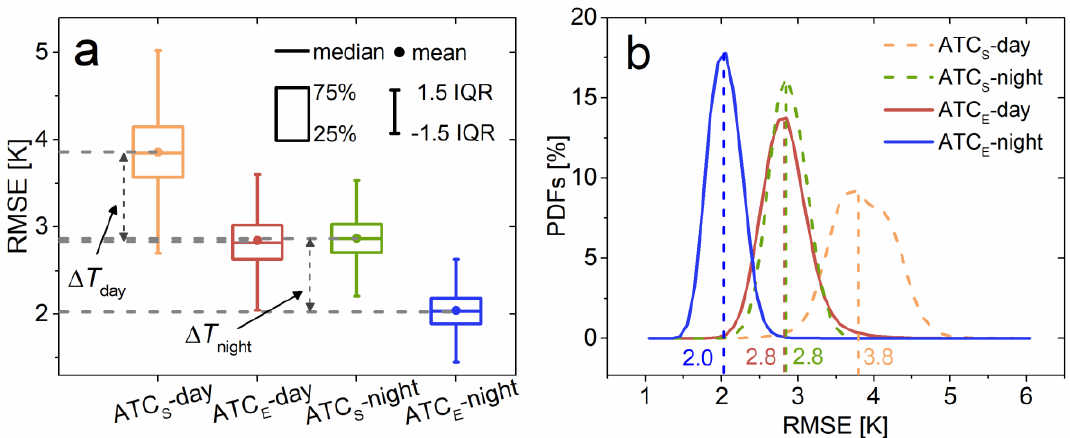
Figure 3. Performances of the ATC S and ATC E for the day and night. ( a ) is the boxplot on the predicted RMSEs, while ( b ) denotes the probability distribution functions (PDFs) of the associated RMSEs. Δ T day and Δ T night are the accuracy improvements for the ATC E when referenced to the ATC S for the day and night, respectively. The end of each whisker of the boxplot indicates the highest or lowest value within 1.5 times of the inter-quartile range (IQR).